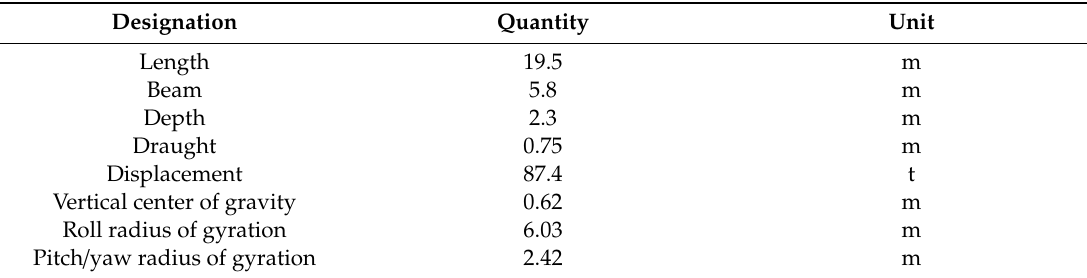
Table 1. The properties of the